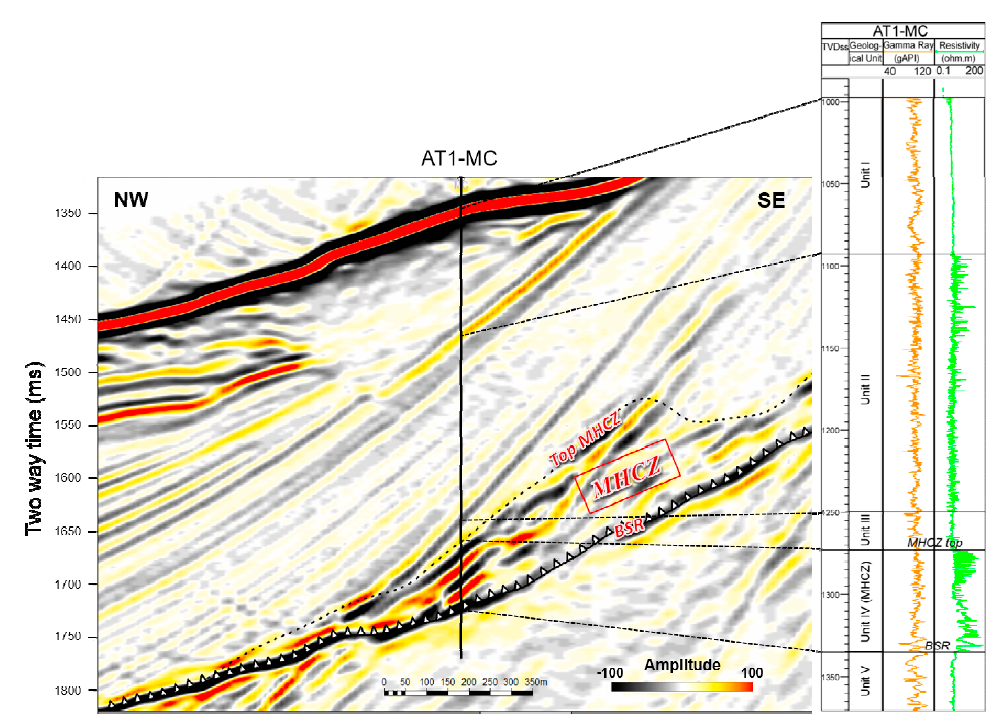
Figure 2. Seismic cross-section through the AT1-MC well and logging data obtained in the AT1-MC well (modified from [9]). The location of the cross-section profile is shown in Figure